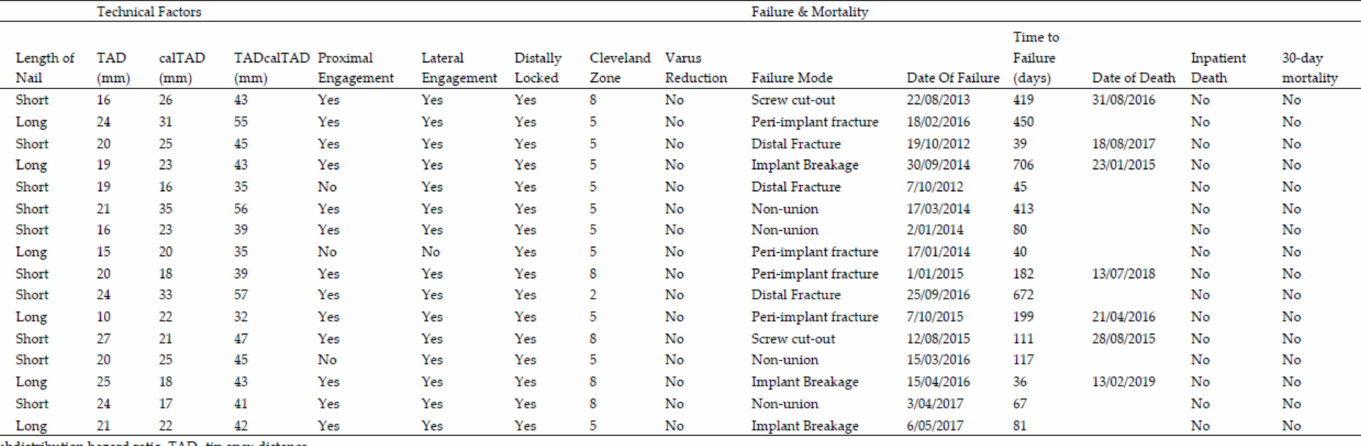
Figure A2. Demographics & Outcomes of Fixation